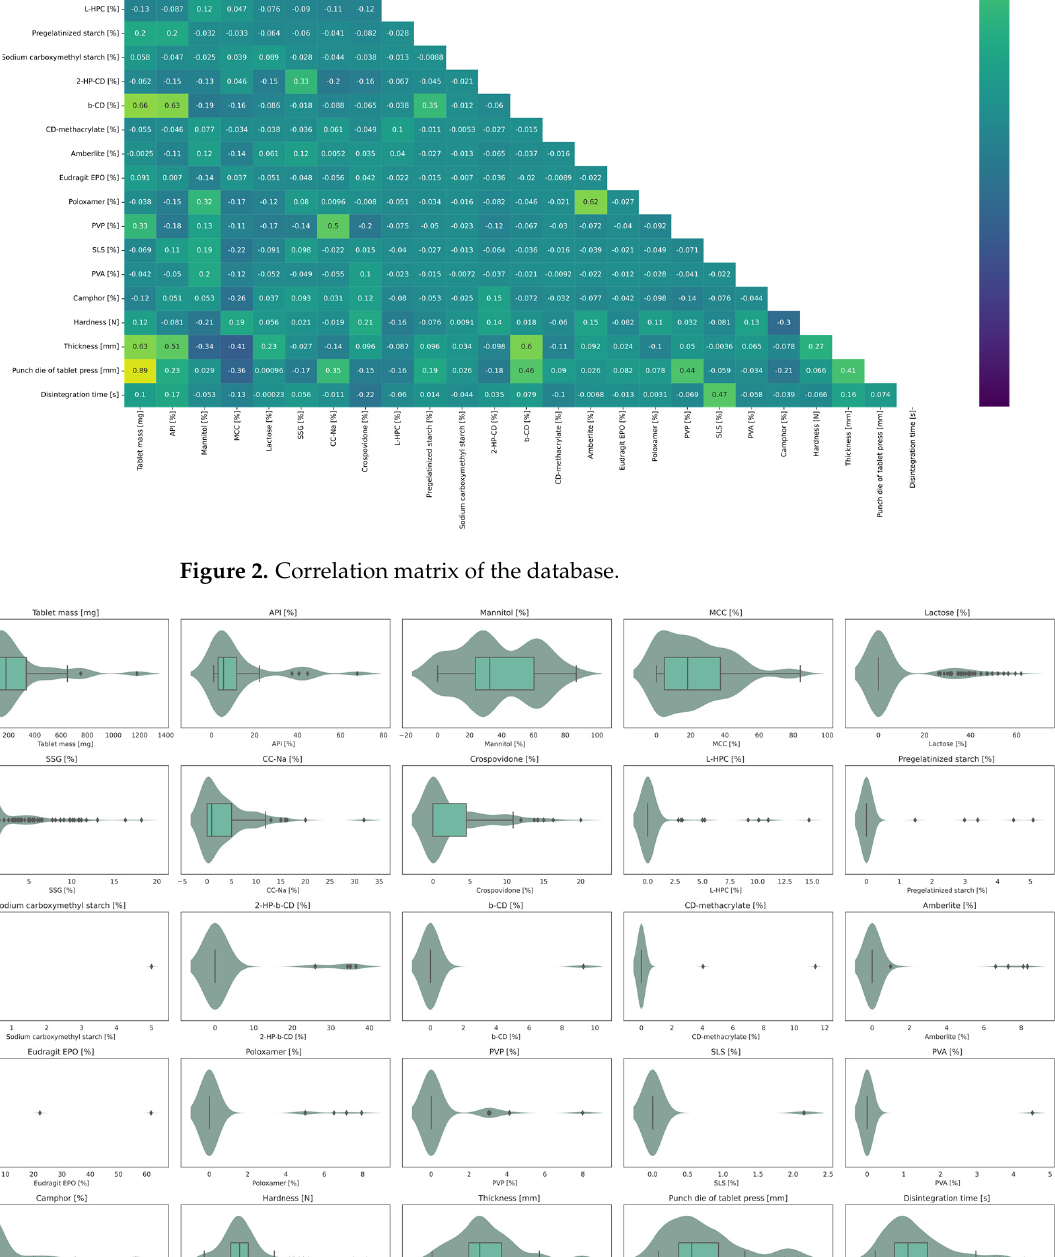
Figure 3. Box and violin plot of selected variables present in the database. Boxes represent inter- quartile range (IQR), namely: first quartile (Q1), median (horizontal line), third quartile (Q3), and the lower whisker = Q1–1.5*IQR; the higher whisker = Q3 + 1.5*IQR; curves represent distributions of numeric data using kernel density function.